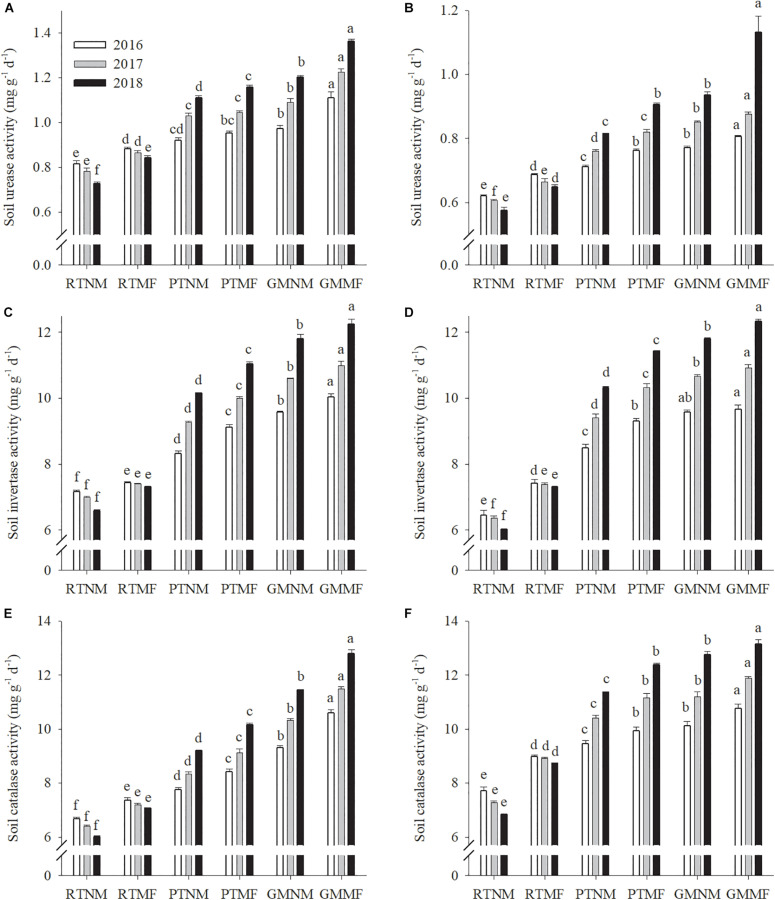
Effects of soil tillage managements and mulching film on soil urease activity (A,B), invertase activity (C,D), and catalase activity (E,F) in the two layers. Vertical bars represent standard error (SE). Mean values ± SE (n = 3). Different letters indicate significant differences among each treatment, P < 0.05.